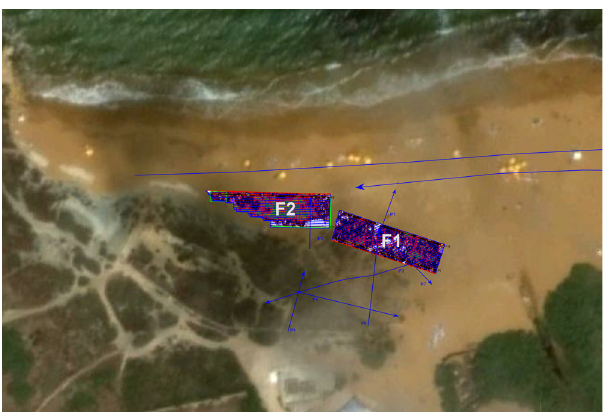
Figure 9: A plan of the GPR surveys undertaken on site. F1 and F2 are the large areas surveyed, while the lines represent the trails ( Source: Heritage Malta ) .